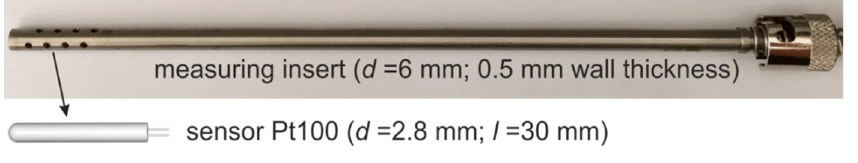
Figure 7. Industrial resistance thermometer used.